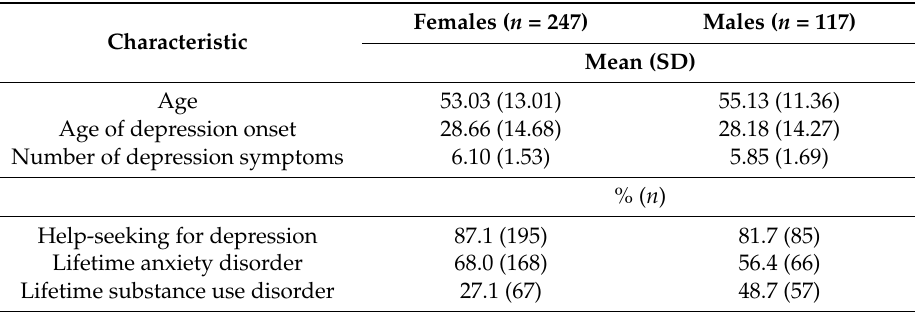
Table 1. Sample characteristics.